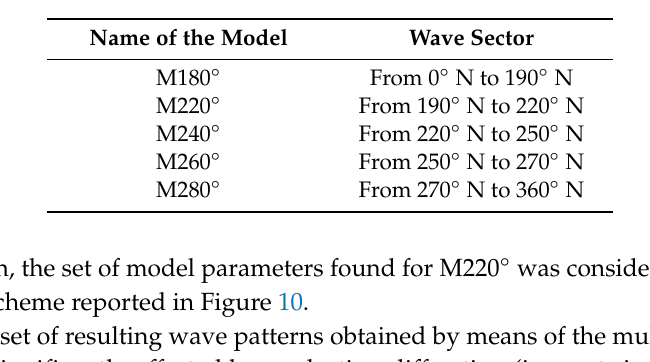
Table 8. Geographical information of nearshore study